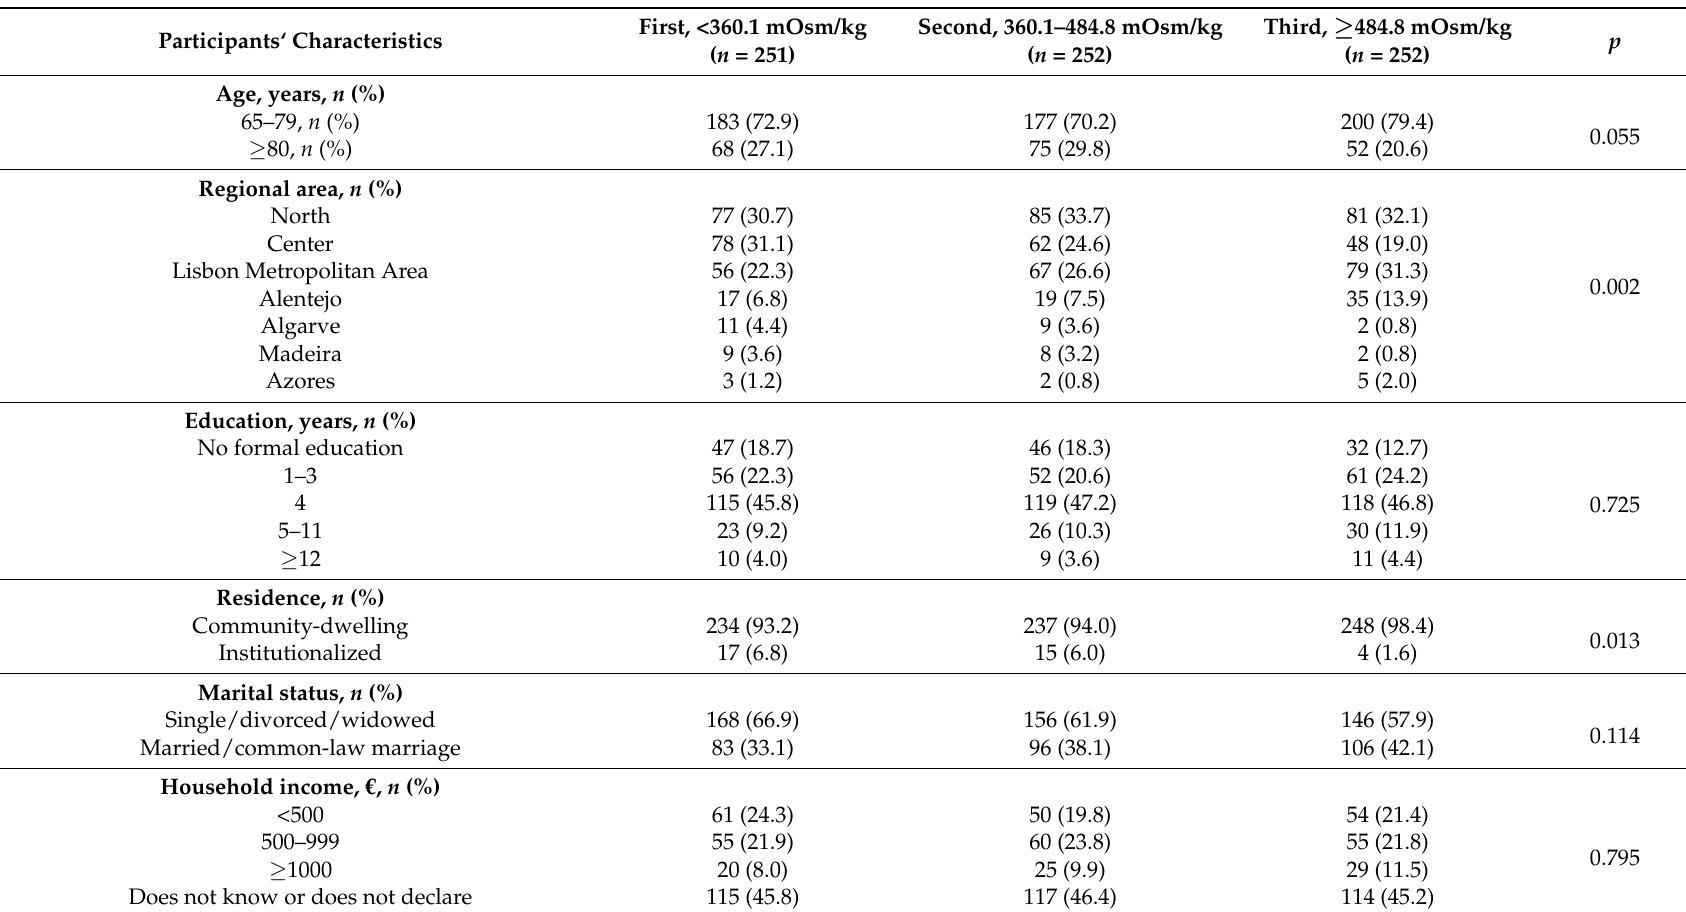
Table 1. Socio-demographic, lifestyle, clinical, anthropometric and nutritional characteristics of 755 older Portuguese women, ≥ 65 years old, participating in a cross-sectional observational study according to osmolality (mOsm/kg)